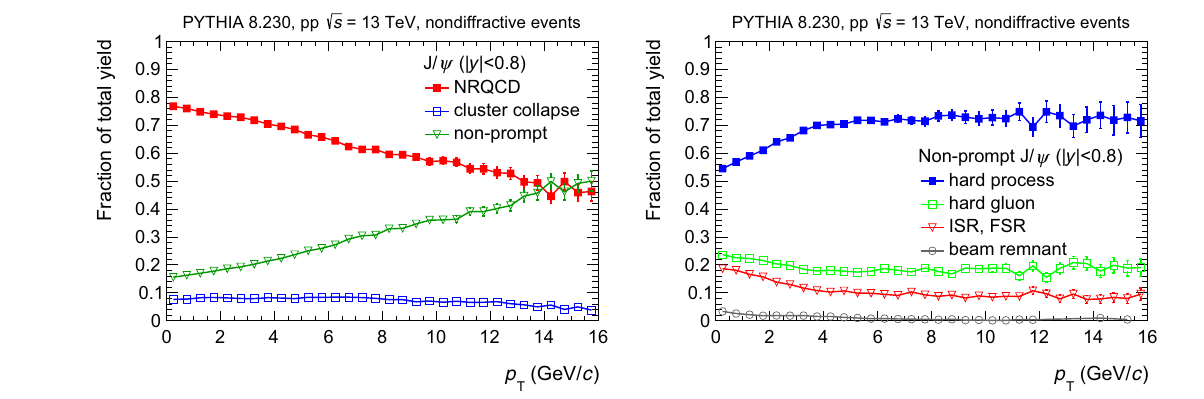
production mechanism to the non-prompt J /ψ yield as a function of transverse momentum in